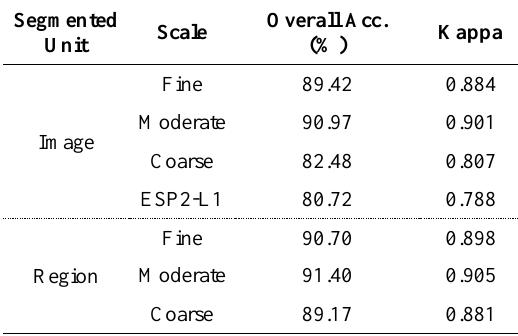
Table 2. Overall accuracies of regional and single-scale